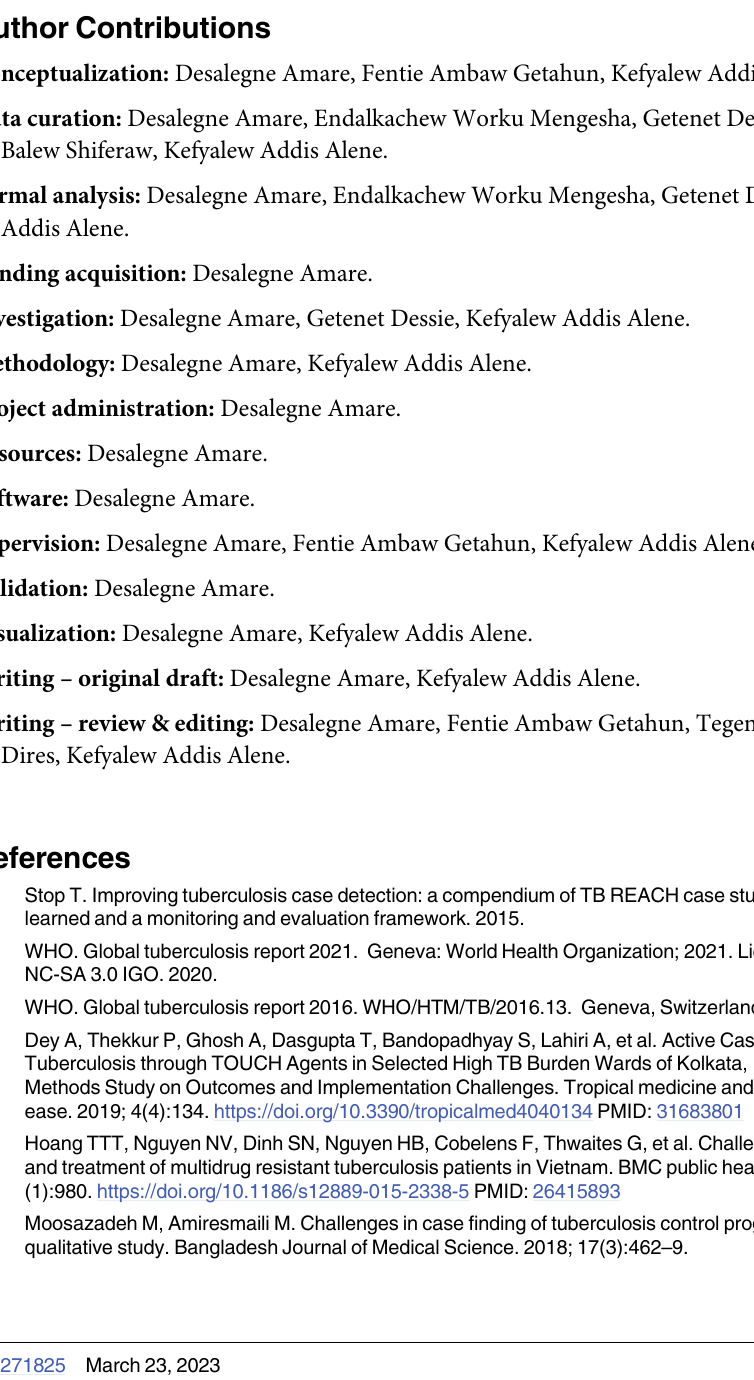
S1 Table. Search key terms. S2 Table. Data collection and risk assessment for RCTs and non-RCTs